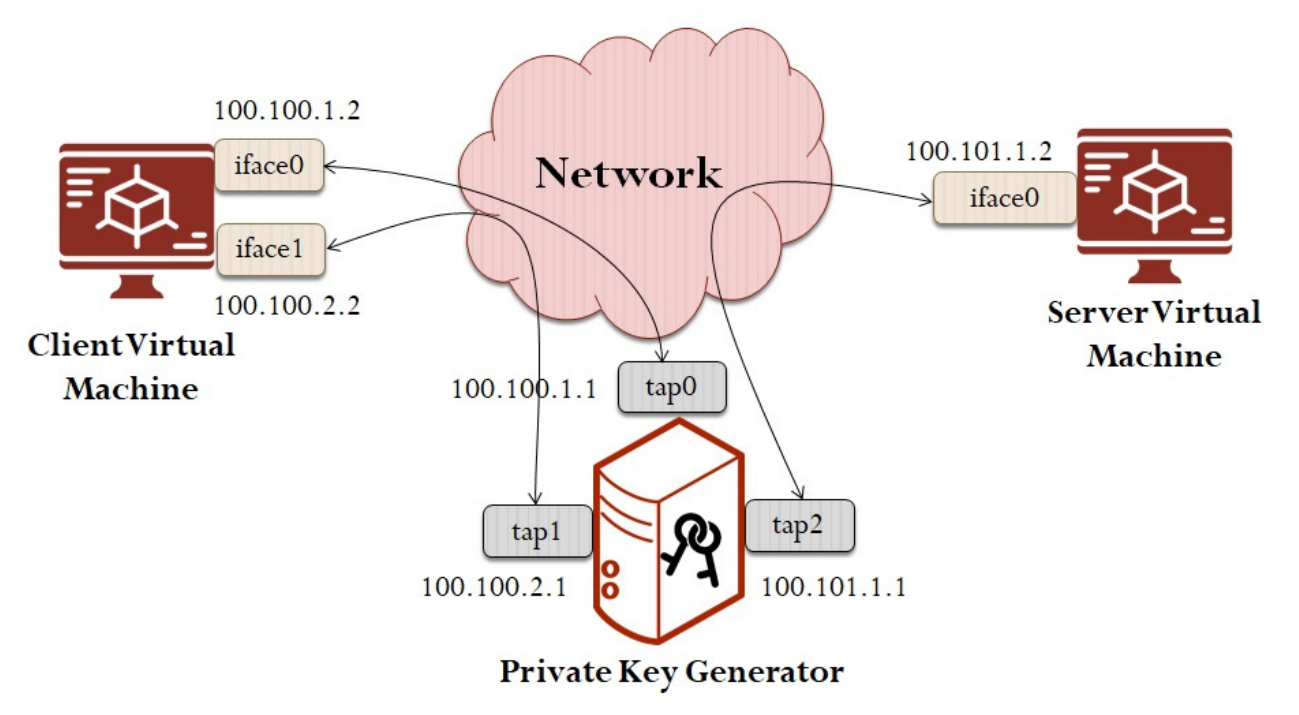
Figure 13. Experimental setup for testing the proposed work.